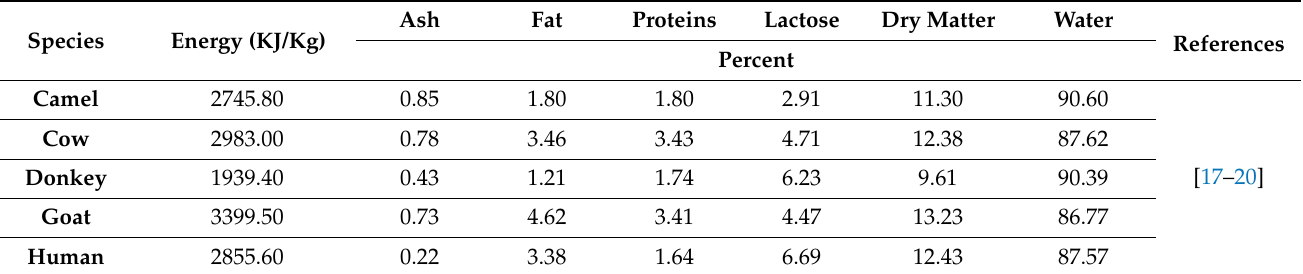
Table 1. Composition of human and animal